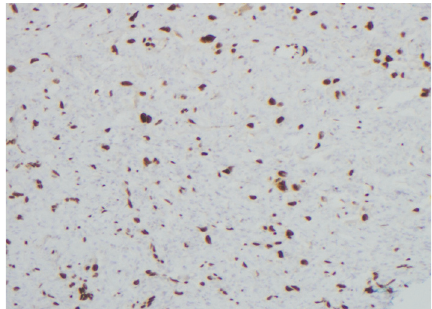
Figure 4: The neoplastic cells also express CD31, a relatively sensi- tive and specific marker for endothelial cells that is also positive in vascular tumors, including angiosarcoma.